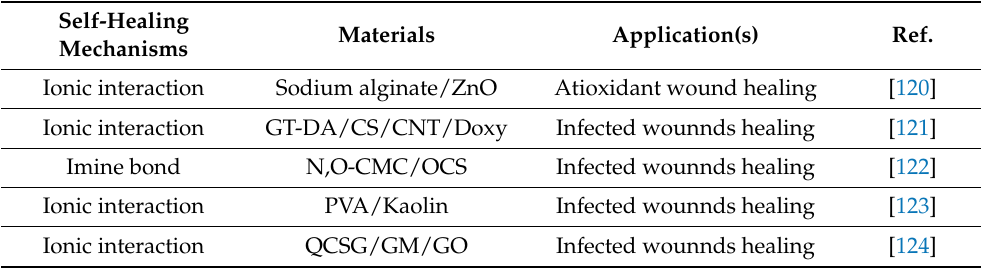
Table 7. A summary of self-healing hydrogels used in vitro and in vivo for wound